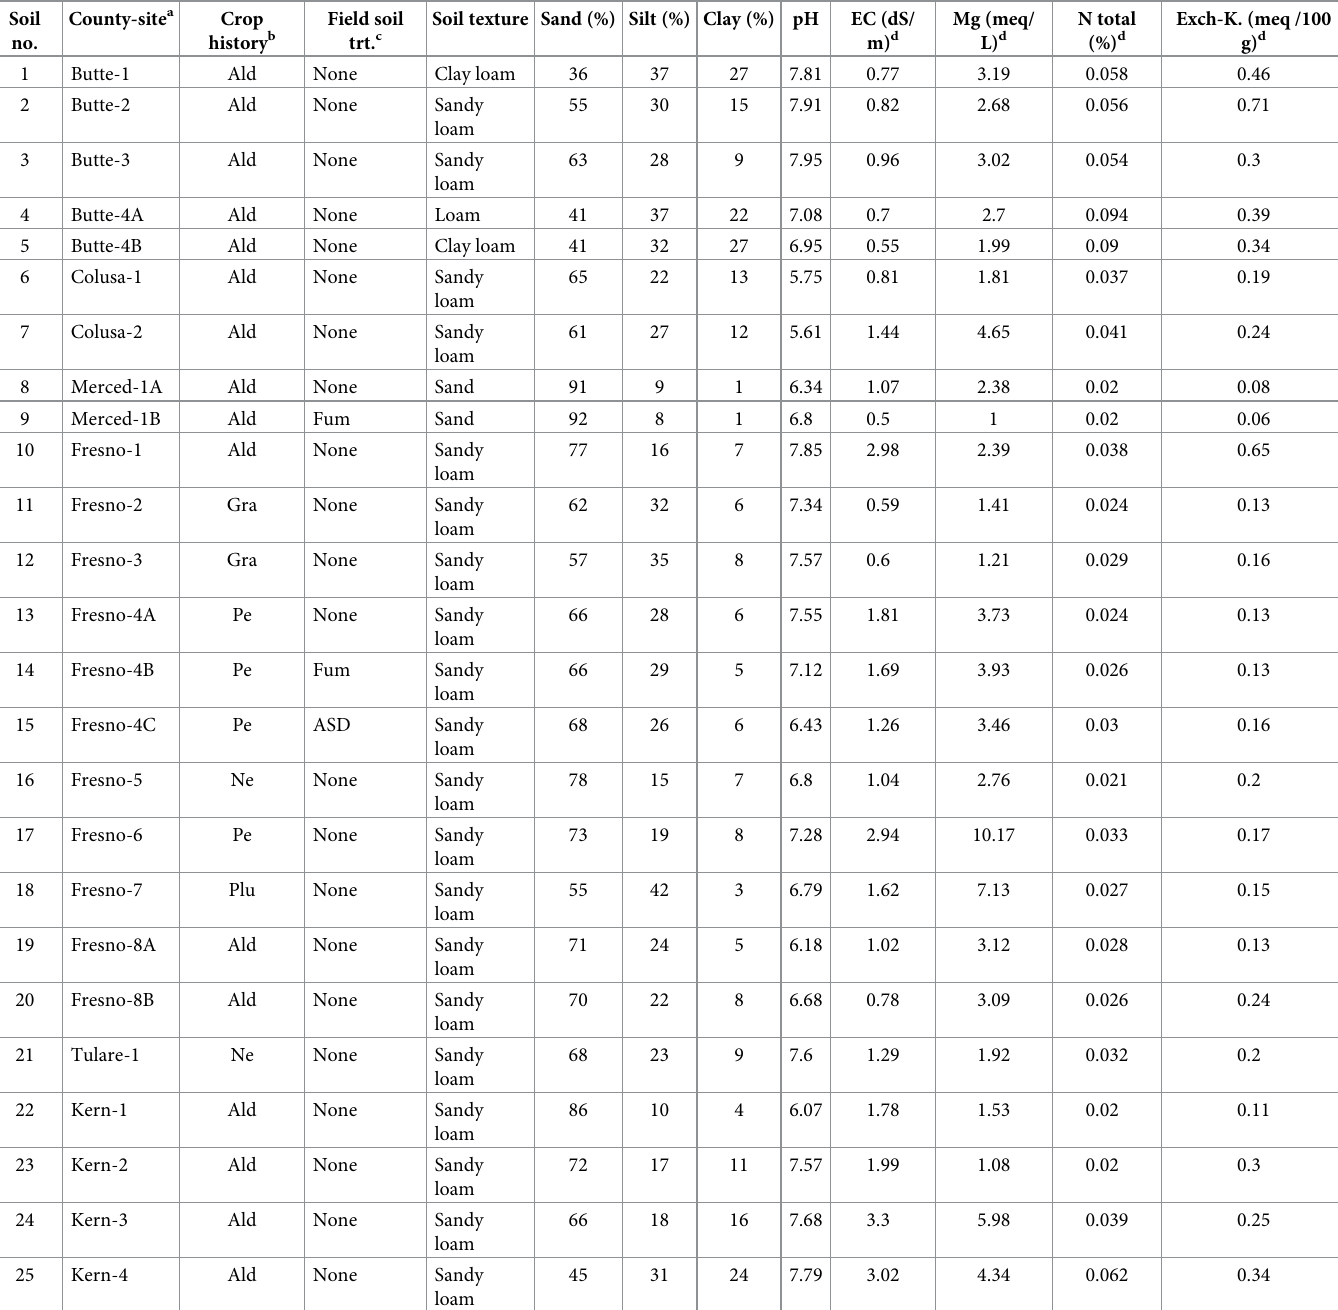
Table 1. Background information and selected physicochemical properties of California soils examined for relationships to Prunus replant disease. Soil